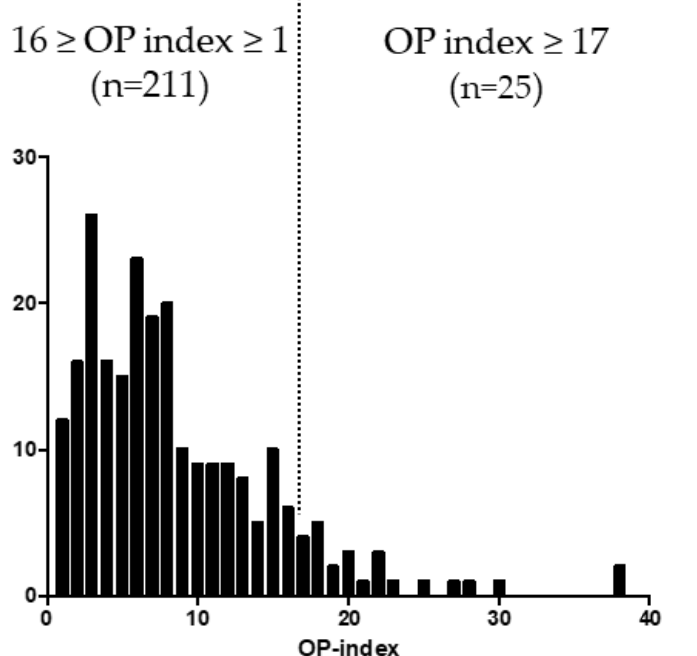
Figure 1. The distribution of OP index values.